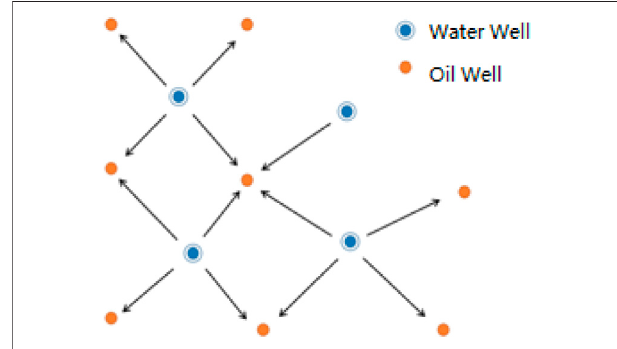
FIGURE 1 | Schematic diagram of water injection wells and their surrounding oil wells.